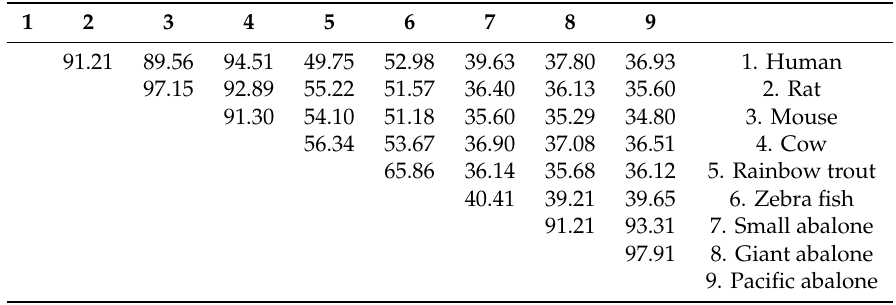
Table 1. Pairwise comparison (% of identity) of Hdh IGFBP7 with IGFBP7 of other gastropod mollusks, eutherian mammals, and piscine vertebrates.